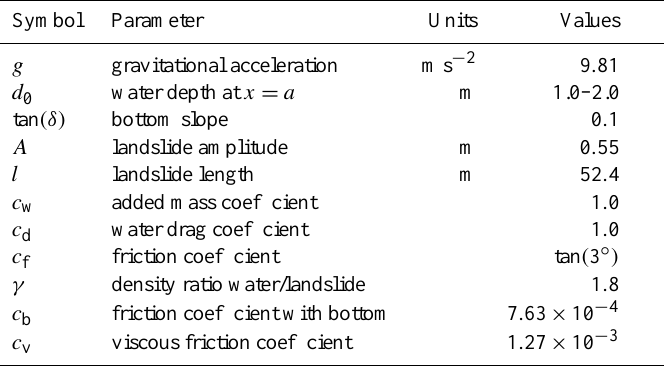
Table 2. Values of various parameters used in numerical computations.